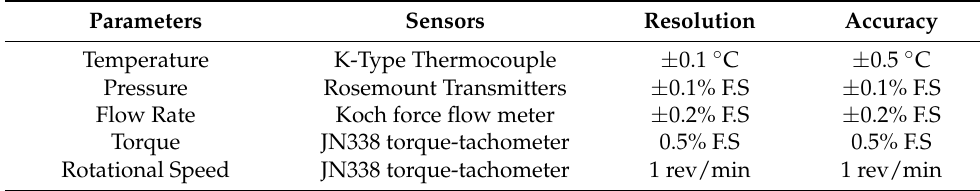
Table 2. Accuracy of sensors in the ORC test rig.